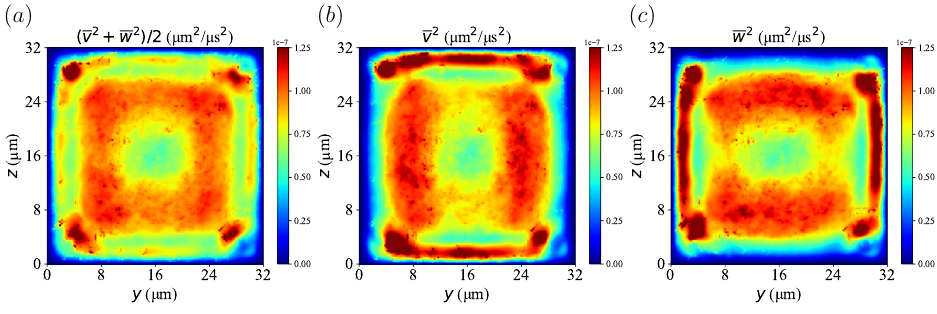
Figure 13. Velocity fluctuation calculated from time-averaged and spatially averaged velocity compo- nents from plasma in Ht = 20% at ˙ γ w = 1990 s − 1 . ( a ) Velocity fluctuation from both the transverse y - and z -direction. ( b ) Velocity fluctuation of the y -direction. ( c ) Velocity fluctuation of the z -direction.